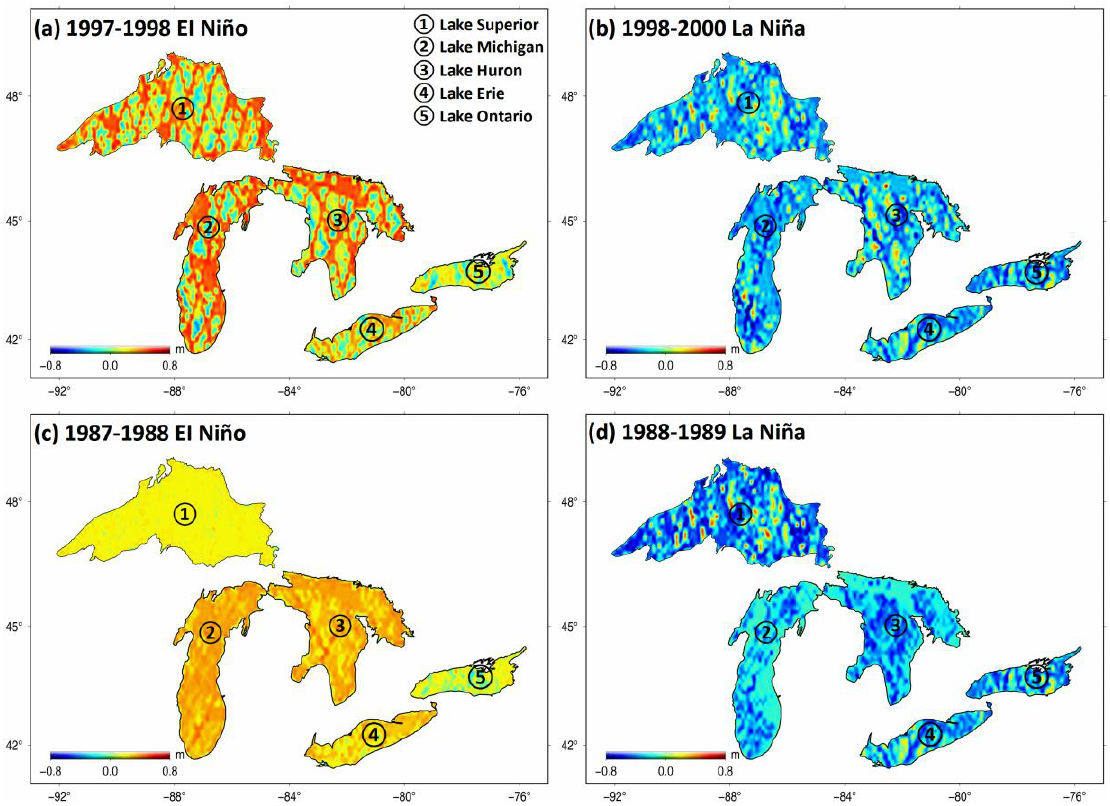
Figure 8. Interannual variations of lake levels during ( a ) the 1997 – 1998 EI Niño; ( b ) 1998 – 2000 La Niña; ( c ) 1987 – 1988 EI Niño; and ( d ) 1988 – 1989 La Niña.